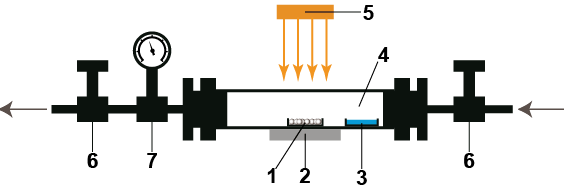
Scheme 1. Diagram of the photocatalytic equipment. (1) Quartz boat for the loading of the TiO 2 catalyst, (2) external heating sleeve, (3) Petri dish containing deionized water, (4) main device constituted by a high-permeability quartz tube and stainless seal flanges, (5) xenon light source, (6) needle valve for the control of the gas flow rate, (7) air gauge displaying the pressure variation in the reaction device. The arrows indicate the flow direction.